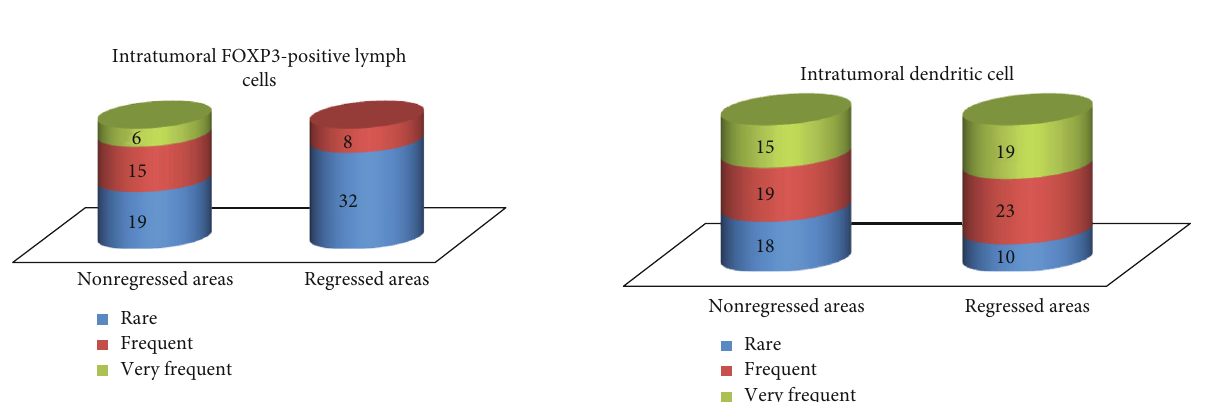
Figure 10: Distribution of FOXP3-positive lymph cells within the tumor. Figure 11: Distribution of dendritic cells within the